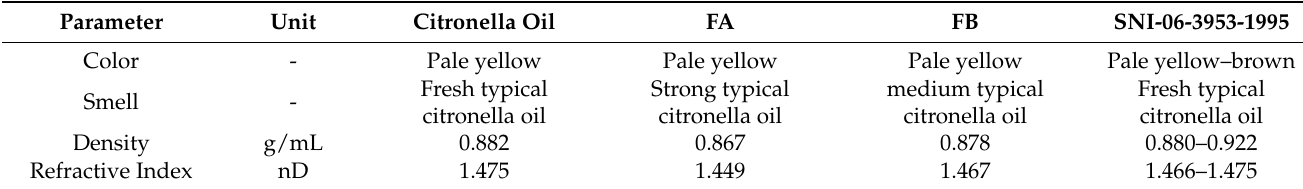
Table 4. Physical Characteristics of Citronella Oil and Its